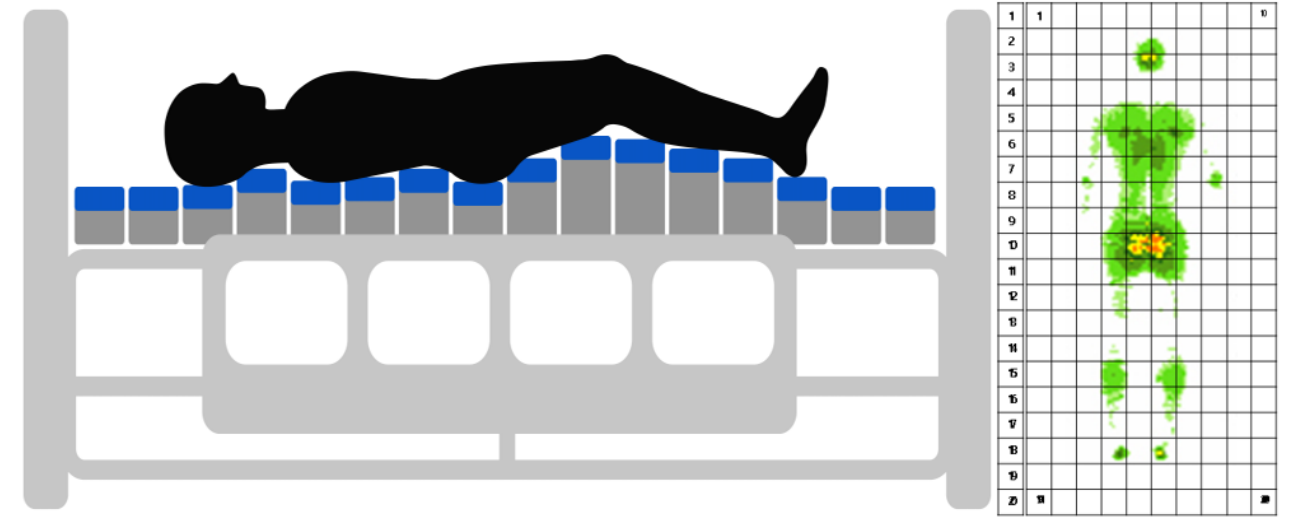
Figure 1. Example of a patient laying down on our proposed smart bed. As can be seen, the bed is designed to have an individual adjustable matrix layout that functions alongside imbedded sensors that continuously collect data of the patient’s posture. The sensor layout has been shown in the form of a grid matrix where each box represents a sensor (Courtesy: Ninebell Co., Ltd., Seongnam, Korea).